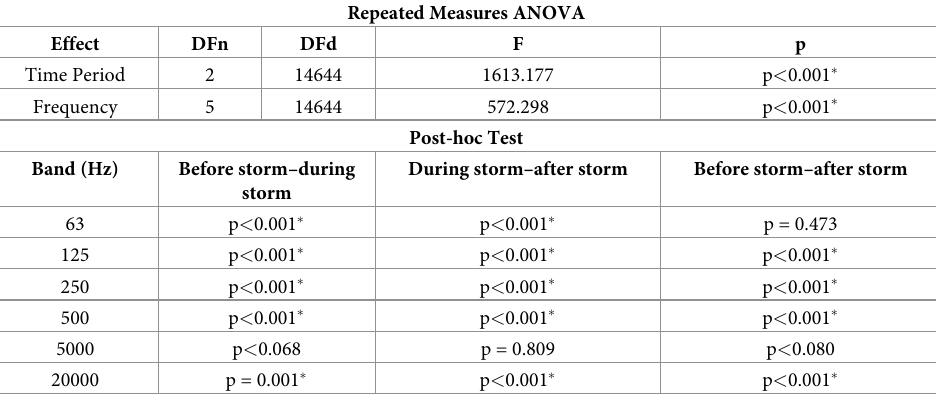
Table 2. Repeated measures ANOVA and post-hoc test for Gulf 1 sound pressure